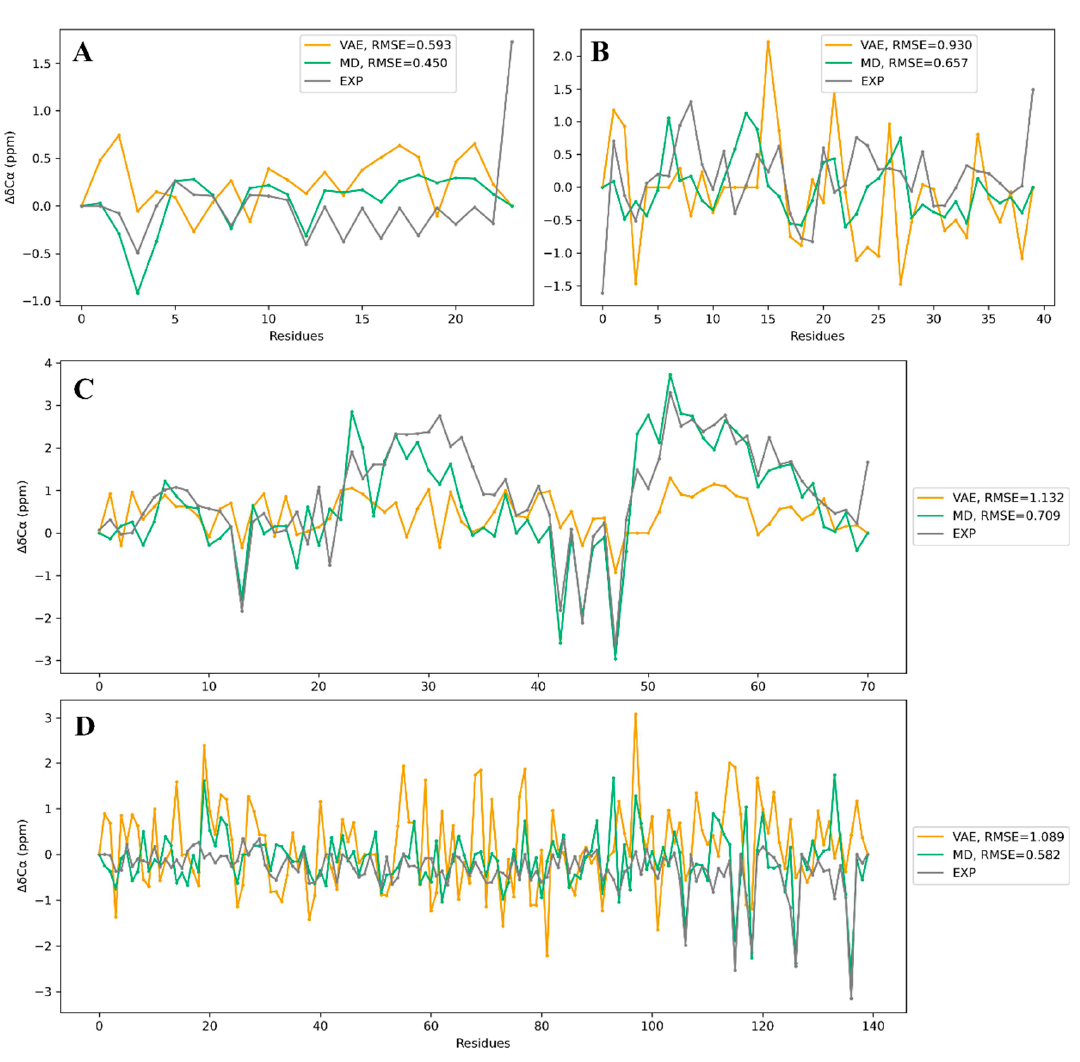
Figure 4. Chemical shifts of VAE-generated conformations and MD trajectories compared to experimental data. Experimental chemical shift data of R17 are missing, so R17 is not displayed here.